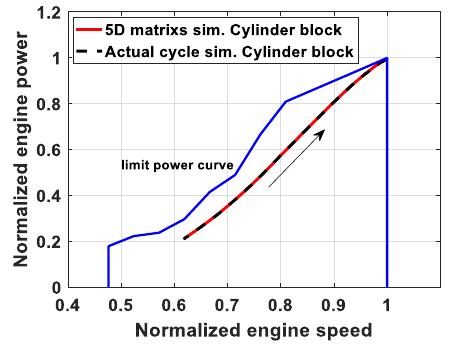
Figure 6. Ship acceleration in the engine map.